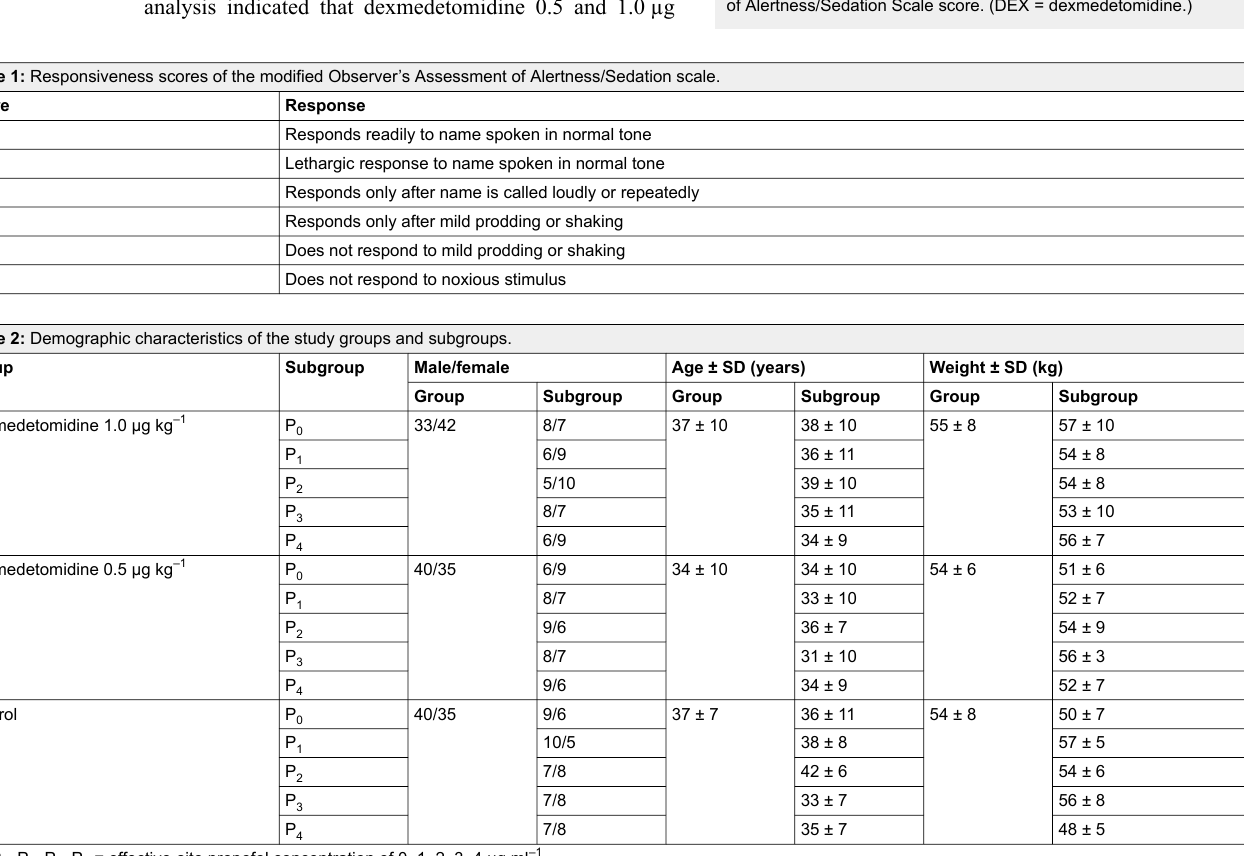
Table 1: Responsiveness scores of the modified Observer’s Assessment of Alertness/Sedation scale.